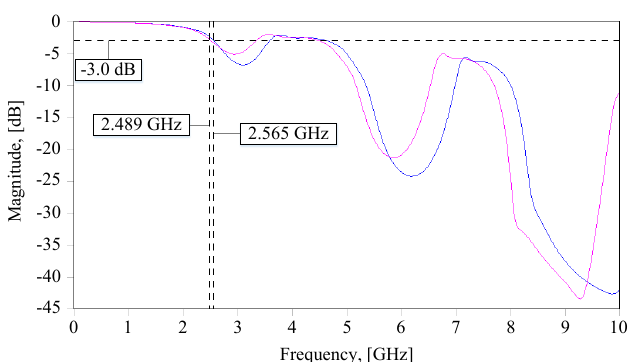
Fig. 8. Comparison of magnitude frequency response of the traditional (blue) and triangle-shaped (pink) meander lines, when Z 0 = 50 Ω . Hence, it is possible to have more stable performance but with a lower bandwidth by applying the meander with a triangle-shape connecting